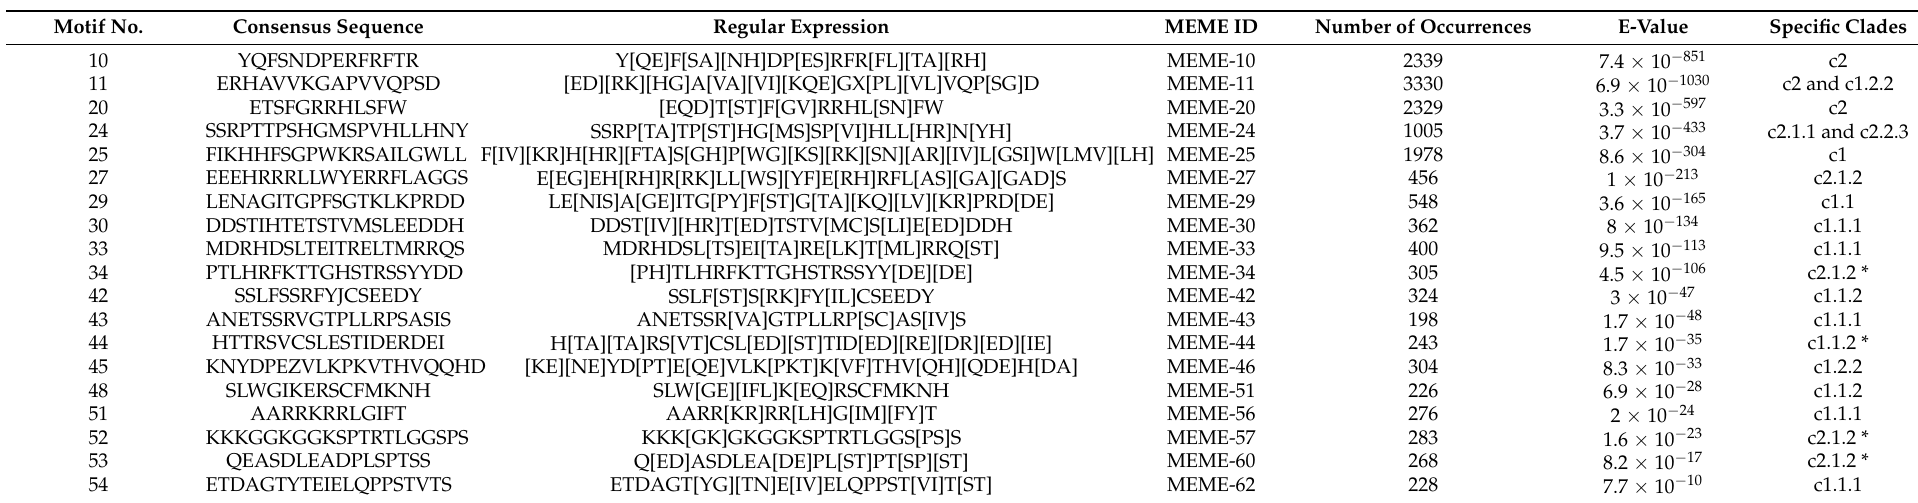
Table 3. Protein motifs with specific distribution in the found phylogenetic